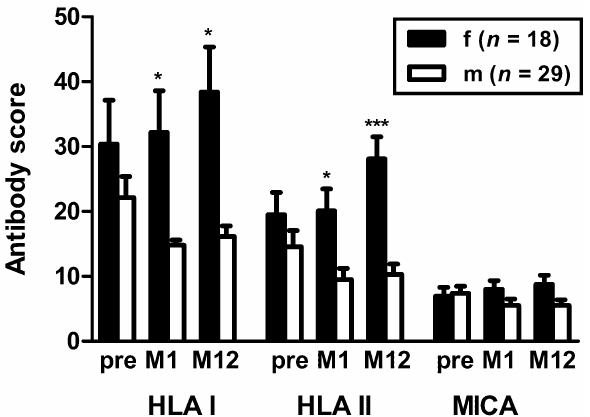
Figure 2. Comparison of HLA/MICA antibodies in female and male kidney transplant recipients vaccinated with Prevenar. The antibody score is the sum of responses to either HLA class I, class II or MICA Luminex™ beads. The data pre vaccination and at month 1 (M1) and month 12 (M12) after vaccination represent mean and standard error of the mean (SEM). Score values in females and males